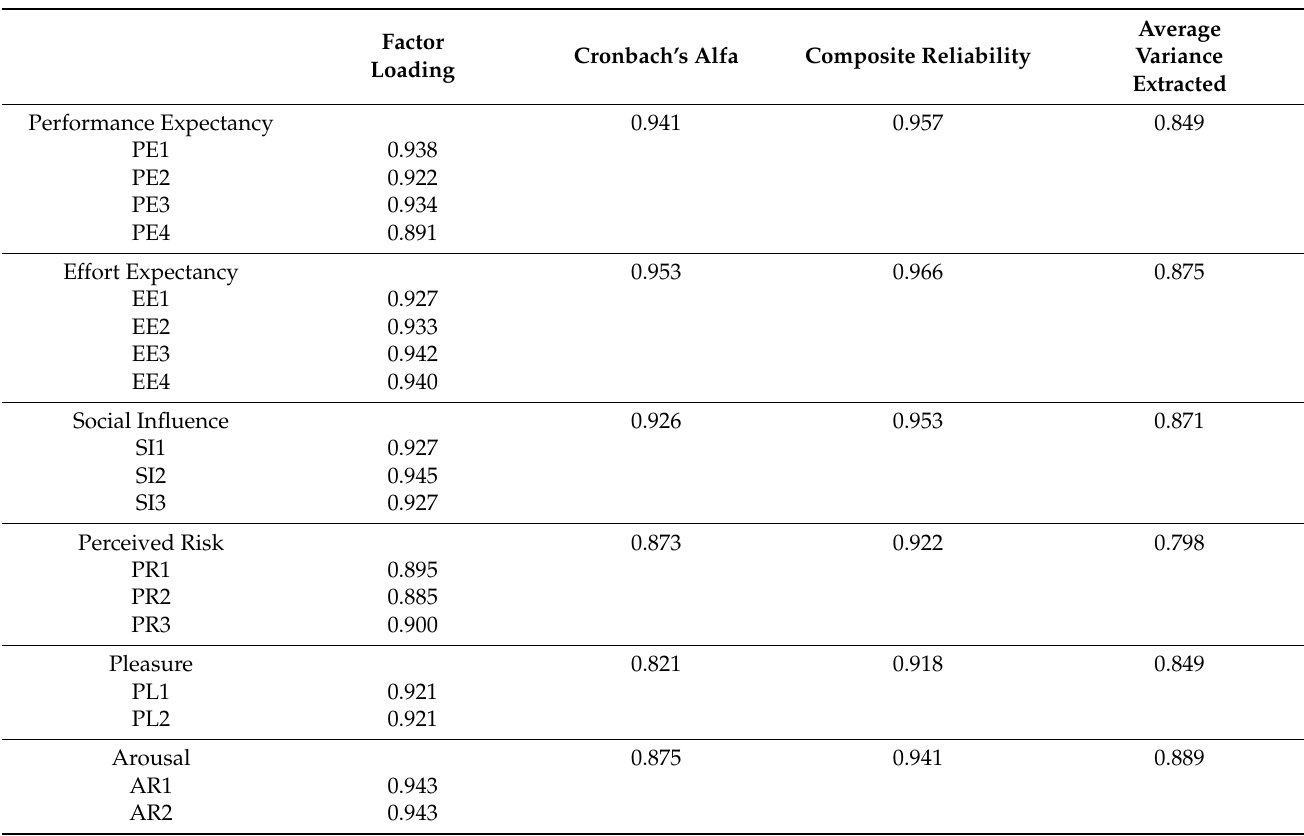
Table 2. Results of the factor analysis and the scale validation measures.